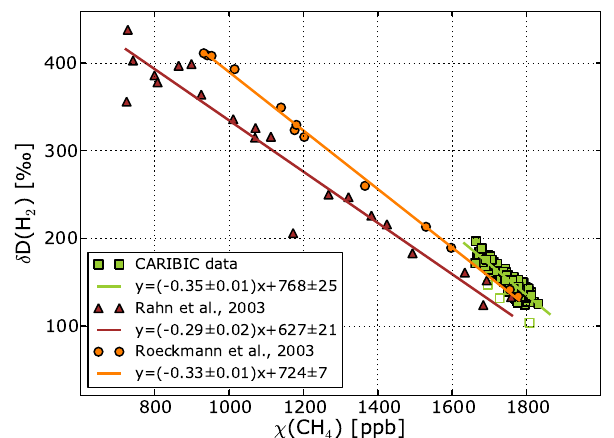
Fig. 6. δ D plotted against χ( CH 4 ) , together with values from Rahn et al. (2003) and R¨ockmann et al. (2003) for comparison. Literature values were multiplied by a factor of 1.0124 to convert them to the NOAA2004 scale. Fits are made with the W-Y algorithm (Cantrell, 2008), without error estimates of the individual measurements for the literature values. Open symbols denote outlying datapoints that were left out of the fitting